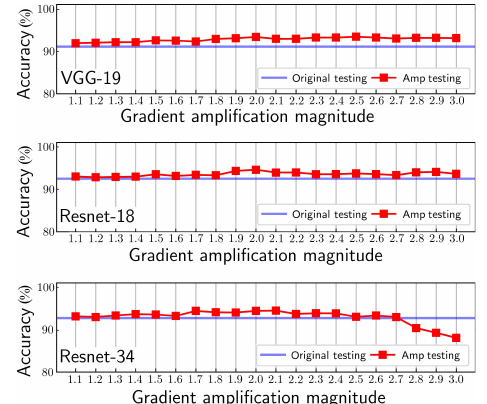
Fig. 5 Performance comparison of amplified models (red) as (cid:0)(cid:0)(cid:0) is varied from 1 to 10 (horizontal axis) vs. original models (blue).